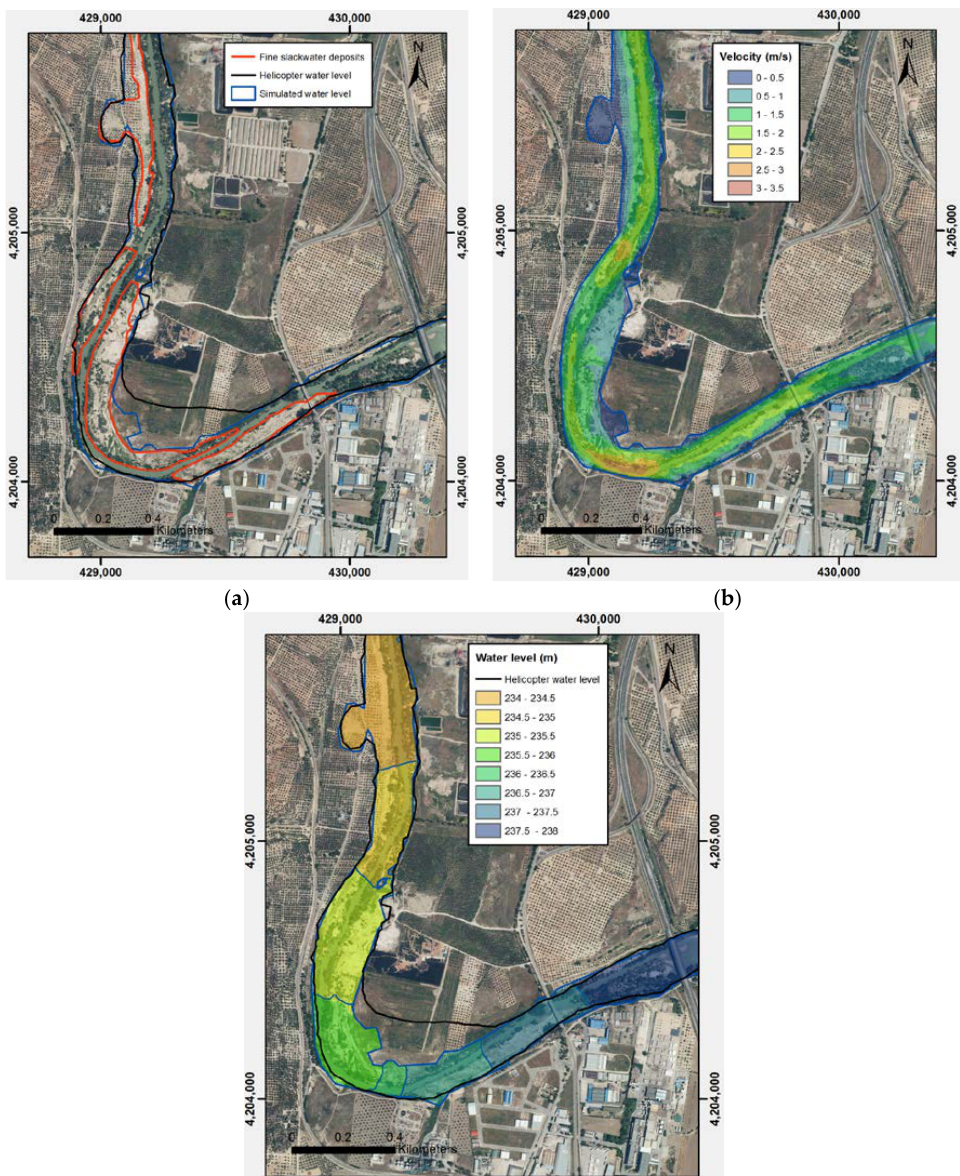
Figure 6. ( a ) Simulated and observed inundation extent, together with slackwater deposits; ( b ) map of simulated velocity magnitude; and ( c ) contours of modelled water surface elevation.